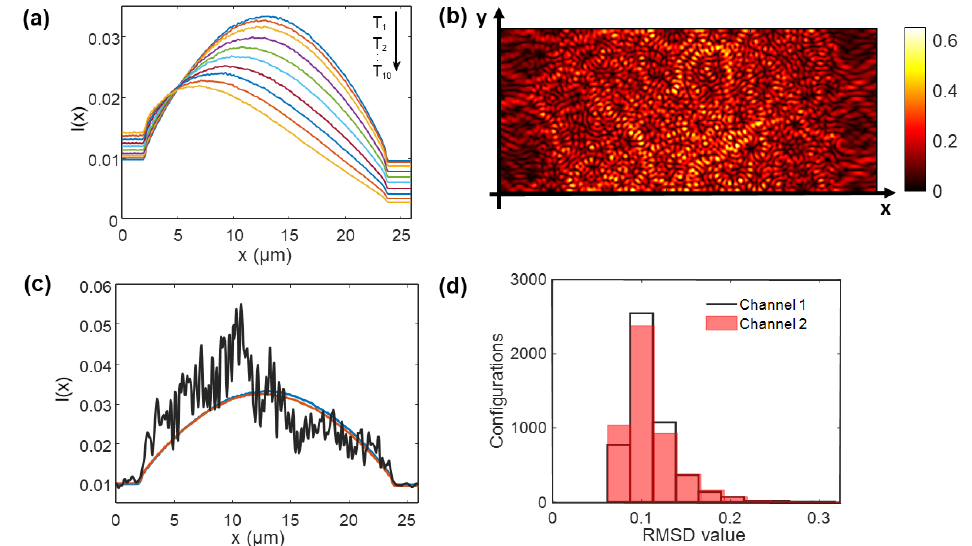
Figure 2. Numerical simulation of disordered photonic structures: ( a ) Numerically calculated spatial profiles of cross-section averaged intensity (proportional to energy density) of transmission eigenchannels with the ten highest transmission eigenvalues of disordered structures with N s = 300. The different spatial profiles of the different transmission eigenchannels are shown in different colors. The intensities were averaged over 10,000 different random configurations. T 1 corresponds to the eigenchannel with the highest transmission eigenvalue; ( b ) Numerically calculated two-dimensional intensity distribution of the transmission eigenchannel with the highest transmission eigenvalue T 1 for a single random configuration with N s = 300; ( c ) Cross-section averaged intensity distribution (corresponding to the two-dimensional intensity distribution shown in ( b )) overlaid on the spatial profiles of transmission eigenchannels T 1 ( blue line) and T 2 ( red line) ( a ); ( d ) Histogram of the root mean square deviation (RMSD) values of 5,000 configurations of the transmission eigenchannels with the highest transmittance (Channel 1) and second-highest transmittance (Channel 2). Both histograms have very similar spread and shape.